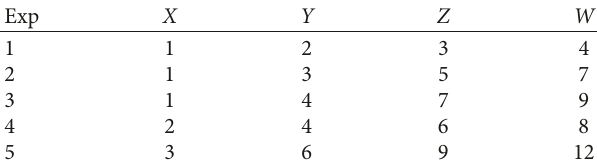
Figure 6: GCALB load distribution algorithm. Table 1: Experiments among four controllers.